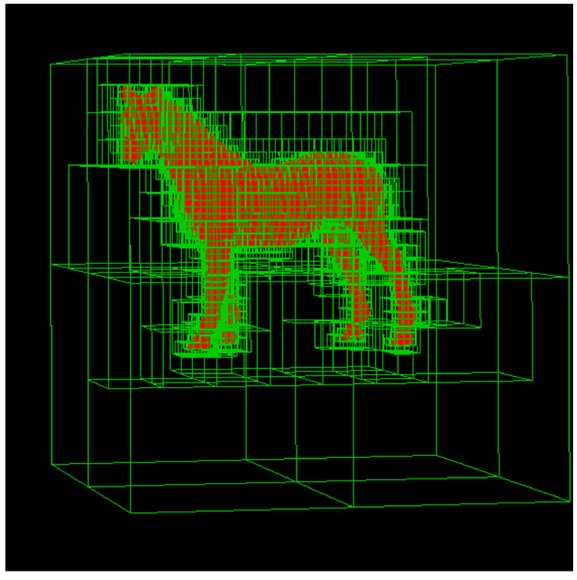
Figure 17. The seventh-level subdivision model of octree grid.